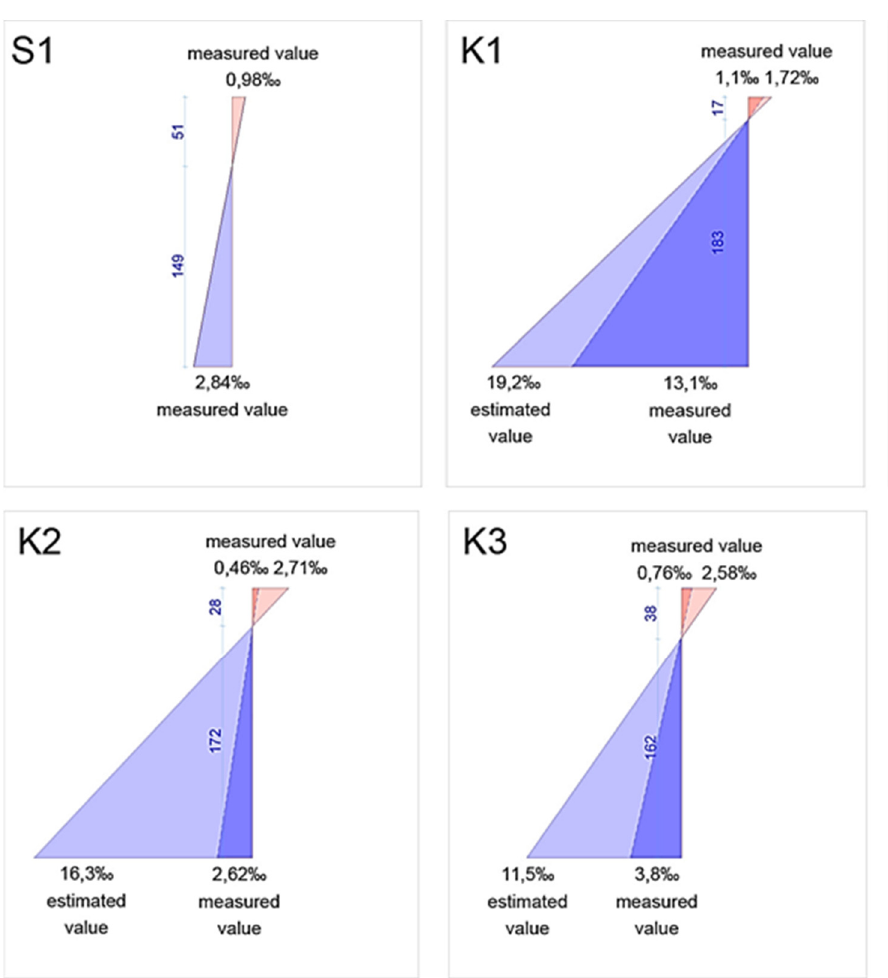
Figure 9. Measured and expected values of deformation in studied beams. The deformations were measured both on rebar (blue) and concrete (red). In the case of beams reinforced with composite rebar, due to the increased deformation of the bars, the strain gauges failed during the tests. The gauges installed in the compression zone registered the deformation until the failure of the beam. The presented graph for beams K1–K3 shows both last measured values (deeper shade of colour) and estimated values (lighter shade of colour) calculated based on the measurements from strain gauges installed on